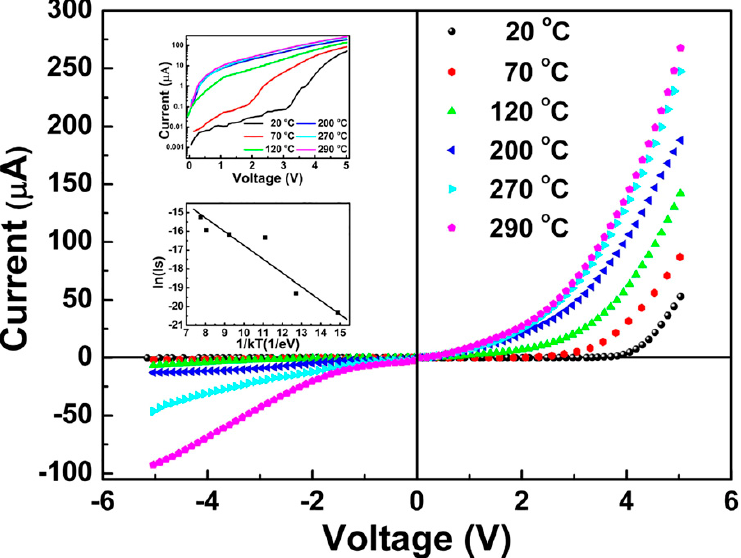
Figure 22. I–V curve of the n-WO 3 NRs/p-BDD heterojunction operating from 20 °C to 290 °C. The top inset is the curve of log I- log V , and the bottom inset is the relation of ln ( I s ) vs. 1/ k B T